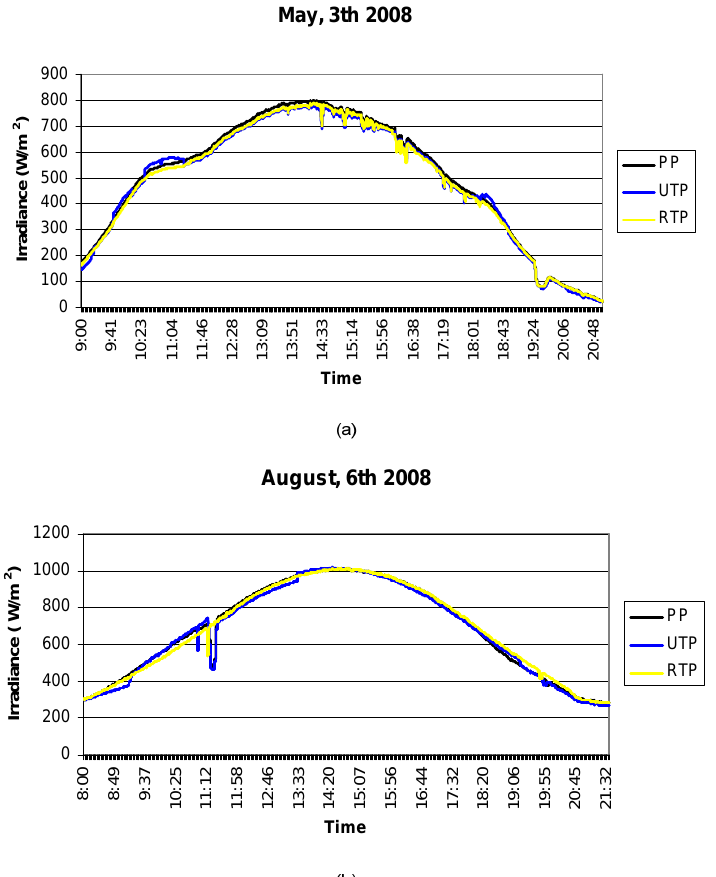
Figure 9. (a)-(d) Irradiance measurements from the three pyranometers (SP is the standard pyranometer, UTP is the unregulated temperature pyranometer and RTP the regulated temperature pyranometer) on four days spread throughout